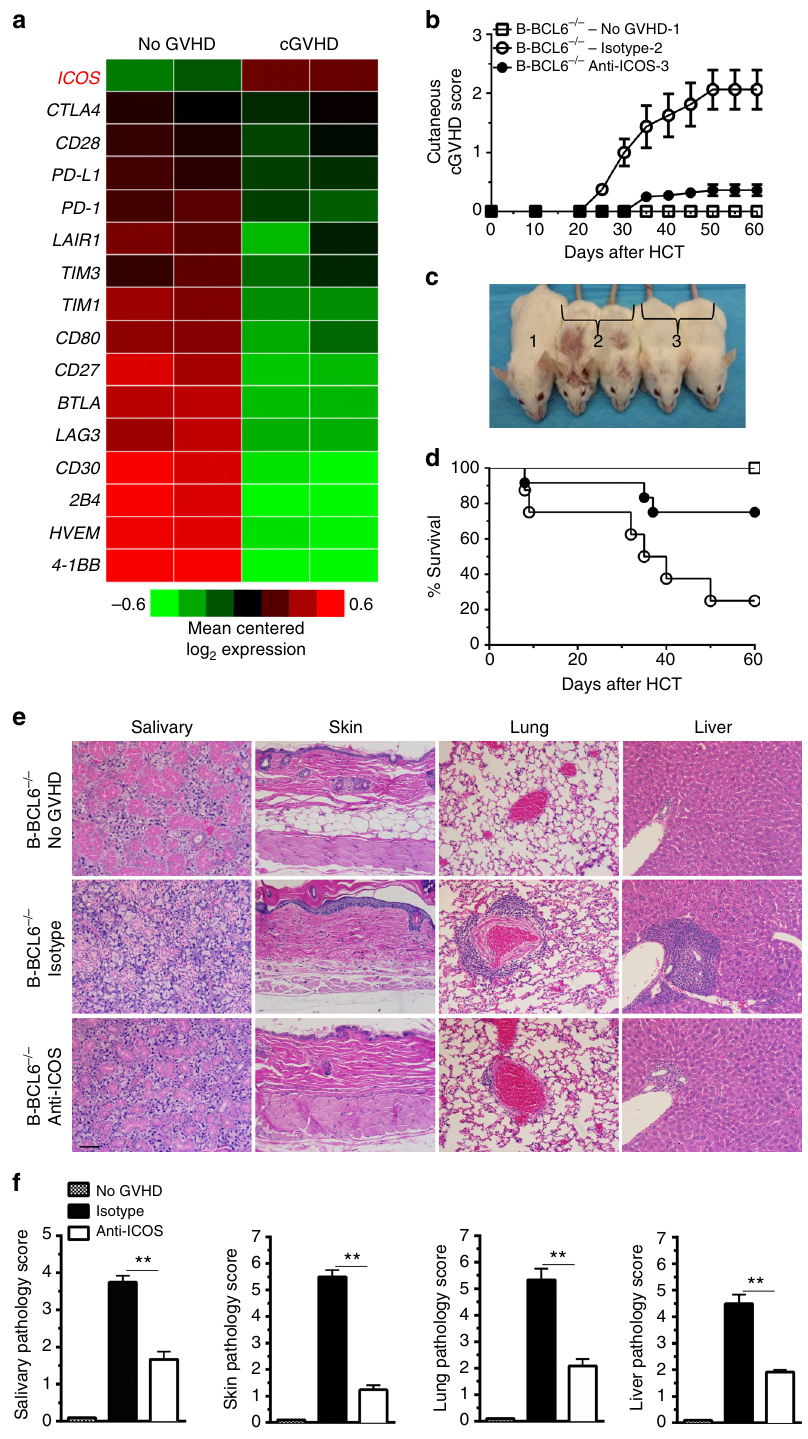
Fig. 4 Anti-ICOS treatment ameliorates cGVHD in recipients without GC formation. a As described in Fig. 3, 21 days after HCT, splenocytes from no-GVHD or cGVHD recipients given wild-type C57BL/6 donor cells were harvested and stained for CD4, CD44, PSGL-1, and CD62L. CD44 hi CD62L lo PSGL-1 lo CD4 + T cells were sorted and used for RNA isolation and RNA-Seq microarray analysis. Heat maps of RNA expression levels of costimulatory and coinhibitory markers are shown as mean centered log 2 expression. RNA-Seq microarray measurements were performed on duplicate samples from no-GVHD group and cGVHD group. Each sample represents splenocytes from eight recipients. b – f BALB/c recipients were irradiated (850 cGy) and given either 2.5 × 10 6 TCD-BM ( n = 8) or 2.5 × 10 6 TCD-BM plus 1 × 10 6 splenocytes ( n = 12) from B-BCL6 − / − C57BL/6 donors. Recipients given 2.5 × 10 6 TCD-BM plus 1 × 10 6 splenocytes were treated with anti-ICOS or isotype control of rat IgG2b, 200 µ g/mouse i.p., starting on day 0 and repeated every other day until day 45 after HCT. Chronic GVHD was monitored. b Cutaneous cGVHD score (Group 3 versus Group 2: P < 0.001 two-way ANOVA). c Picture taken on day 60 after HCT(1 – no-GVHD, 2 – isotype, 3 – anti-ICOS). d Survival curve (Group 3 versus Group 2: P < 0.05, log-rank test). e H&E staining of salivary gland, skin, lung, and liver. f Pathology scores of cGVHD for salivary gland, skin, lung, and liver are shown as mean ± SE ( n = 6). ** P < 0.01, unpaired two-tailed Student ’ s t test. Scale bar , 50 µ